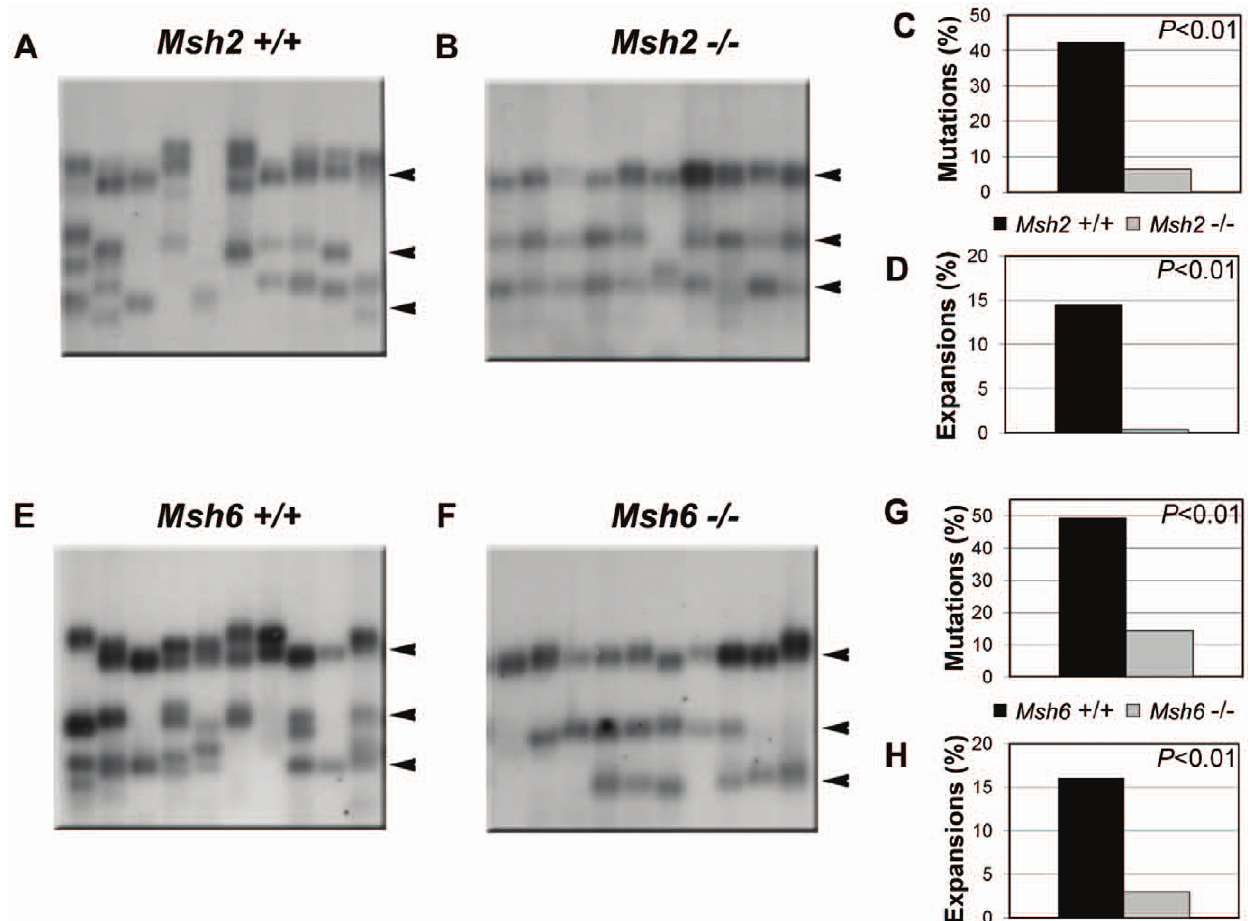
Figure 1. Absence of MutS a reduces somatic mutation load of the (GAA ? TTC) n sequence. Panels A, B, E, and F show representative autoradiographs from SP-PCR analysis of DNA extracted from (A) Msh2 + / + , (B) Msh2 2 / 2 , (E) Msh6 + / + , and (F) Msh6 2 / 2 cerebellum. Progenitor allele lengths determined by conventional PCR are 192, 130, and 89 repeats for Msh2 + / + ; 188, 128, and 88 repeats for Msh2 2 / 2 ; 186, 133, and 98 repeats for Msh6 + / + ; and 187, 129, and 90 repeats for Msh6 2 / 2 , as indicated by arrowheads at the right of each panel. Results from the total analysis of 150 to 282 molecules per genotype are quantified in C and D for Msh2 , and G and H for Msh6 .